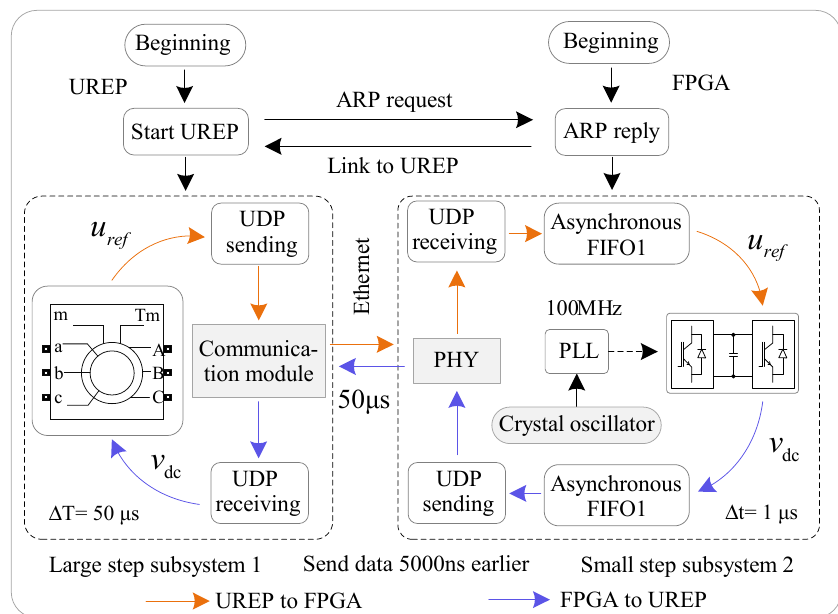
Figure 14. Flow chart showing UDP sending data. The block diagram of FPGA and UREP asynchronous co-simulation is shown in Fig- ure 15.